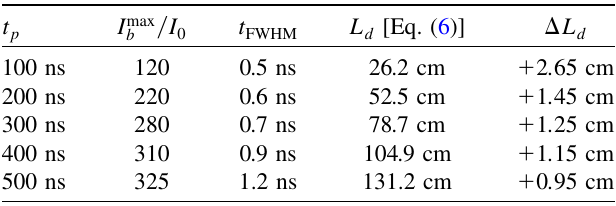
TABLE II. Compression dependence on initial pulse length t (cid:4) 400 keV , T (cid:4) 0 : 2 eV , and an intended f (cid:4) 0 : 5 using for E k 0 the smooth waveform across the 3 cm long gap.